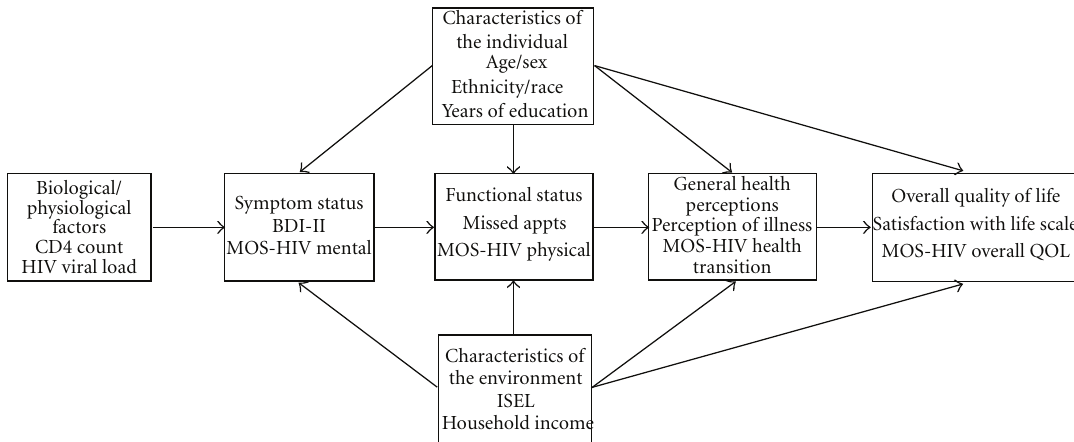
Figure 1: Operationalized Wilson and Cleary model, modified from